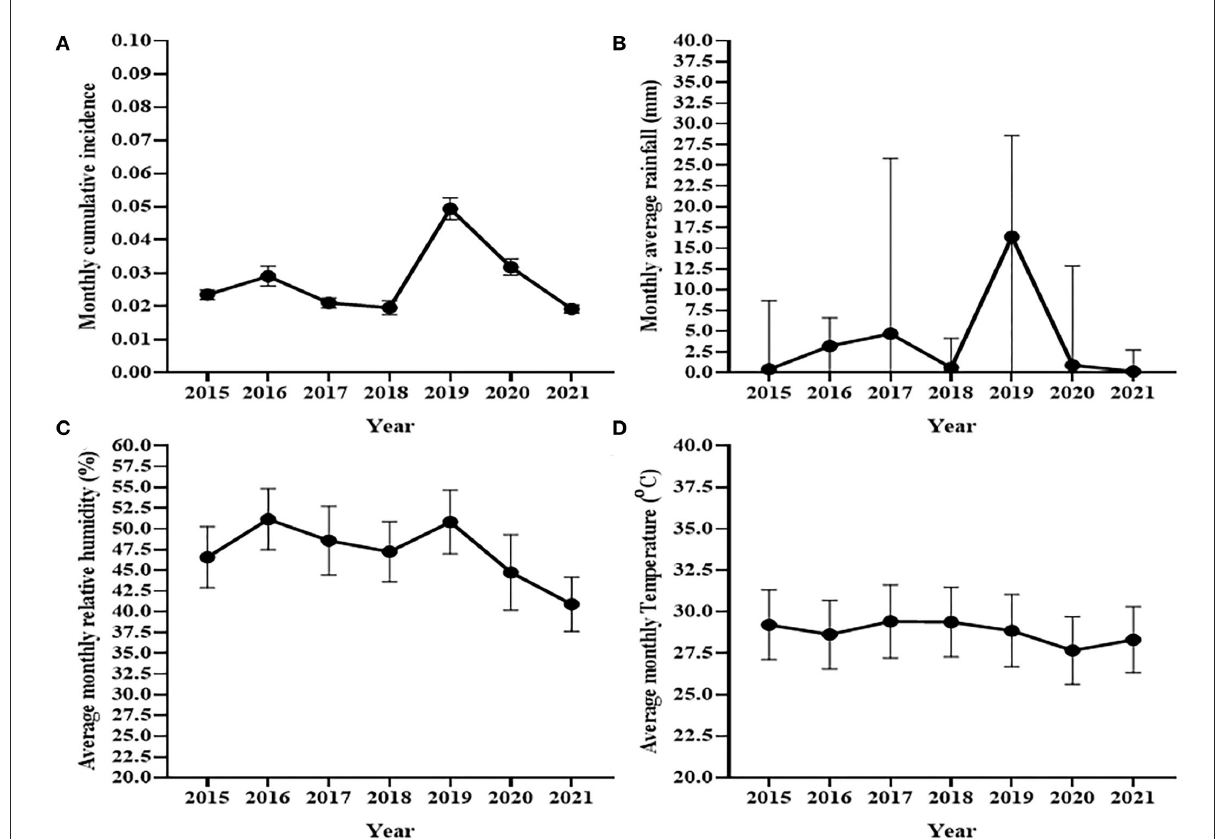
FIGURE2 Trends of cumulative incidence of clinical mastitis at the National Dairy Farm (A) and trend of monthly rainfall (B) , average monthly relative humidity (C) , and average monthly temperature (D) during seven study years. The trend of observed monthly cumulative incidence of clinical mastitis was similar to the trend pattern of rainfall and relative humidity recoded in the areas while it seems different from trend of monthly average temperature recorded in the